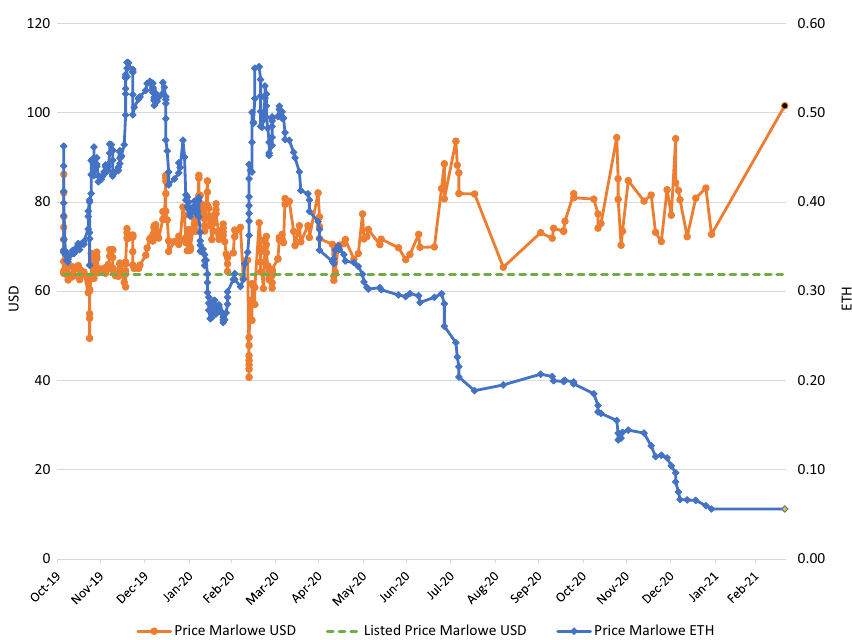
Fig. 7 Price (in USD and ETH) of 9943 Marlowe Street Detroit MI. Each dot represents one transaction. Last colored dot is ask price on